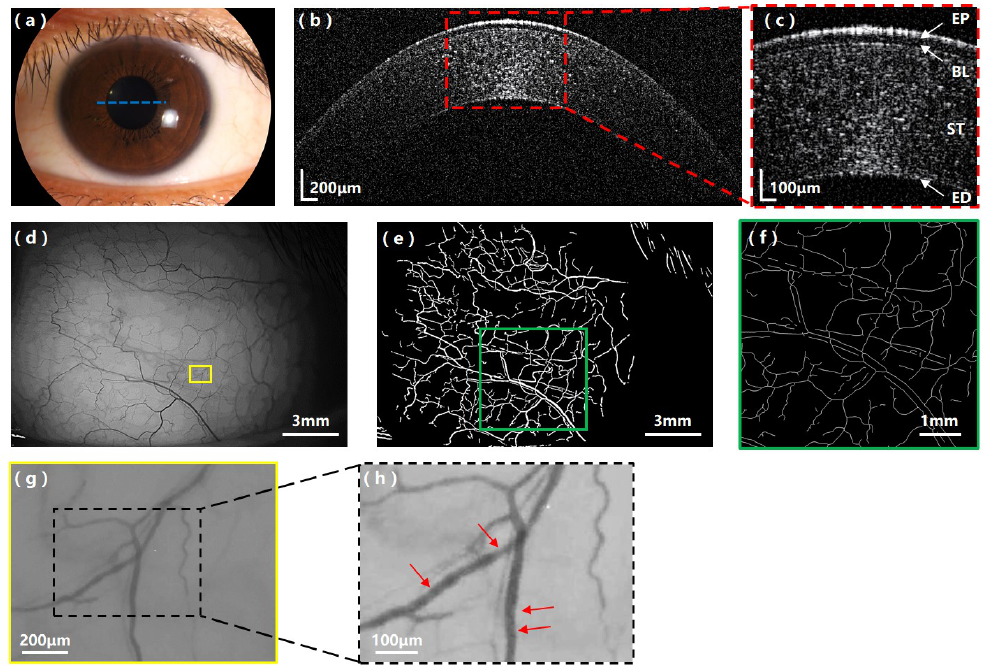
video clip recorded on the healthy subject. From the zoom-in area shown in Figure 3 (h), clusters of red blood cells are visible. The registered video clip (Video s1) shows clearly, the movement trajectories of red blood cells, which were used by the software to calculate the hemodynamic results. The calculated quantitative results of the healthy subject are: mean vessel diameter D = 17.84 ± 1.52 μm, cross-sectional area = 251.40 ± 44.43μm 2 , axial blood flow velocity V a = 0.26 ± 0.07 mm/s, cross-